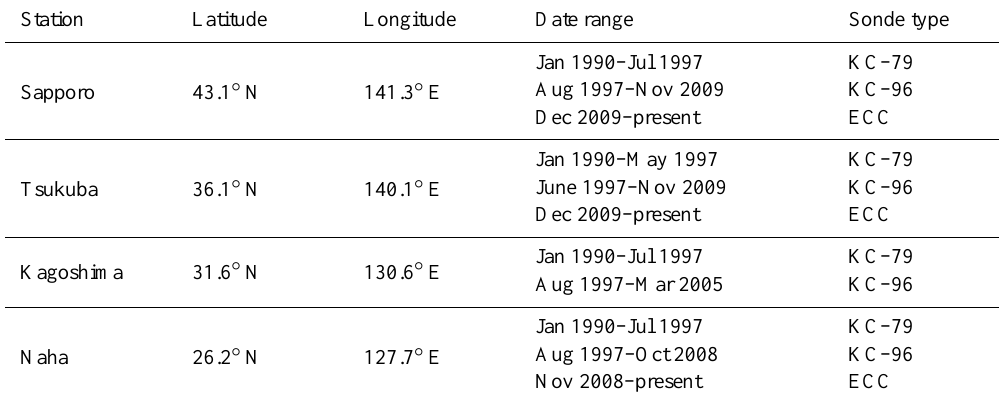
Table 1. Information for the Japanese ozonesonde stations used in this study. Station Latitude Longitude